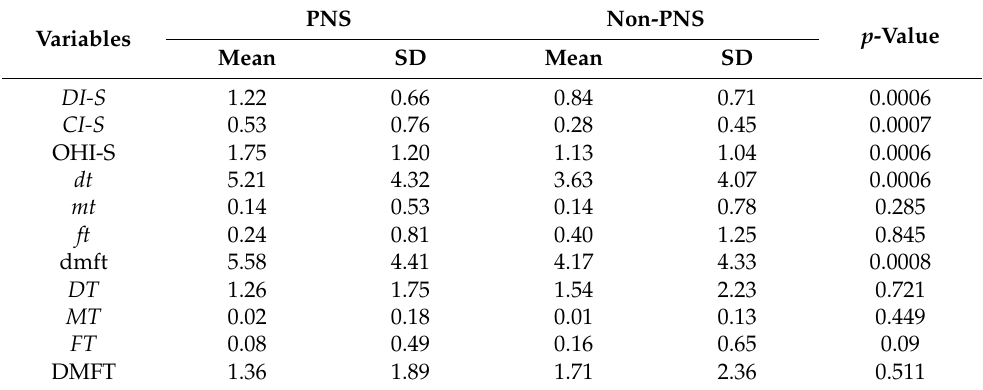
Table 3. Comparison of OHI-S, GI, GOI, and dmft/DMFT indices between PNS and non-PNS